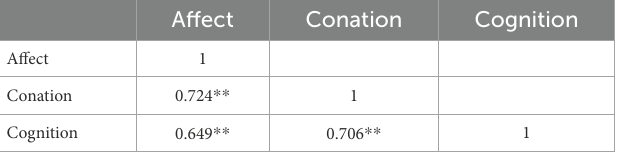
TABLE 3 Pearson correlation coefficient table for cognition, affect, and